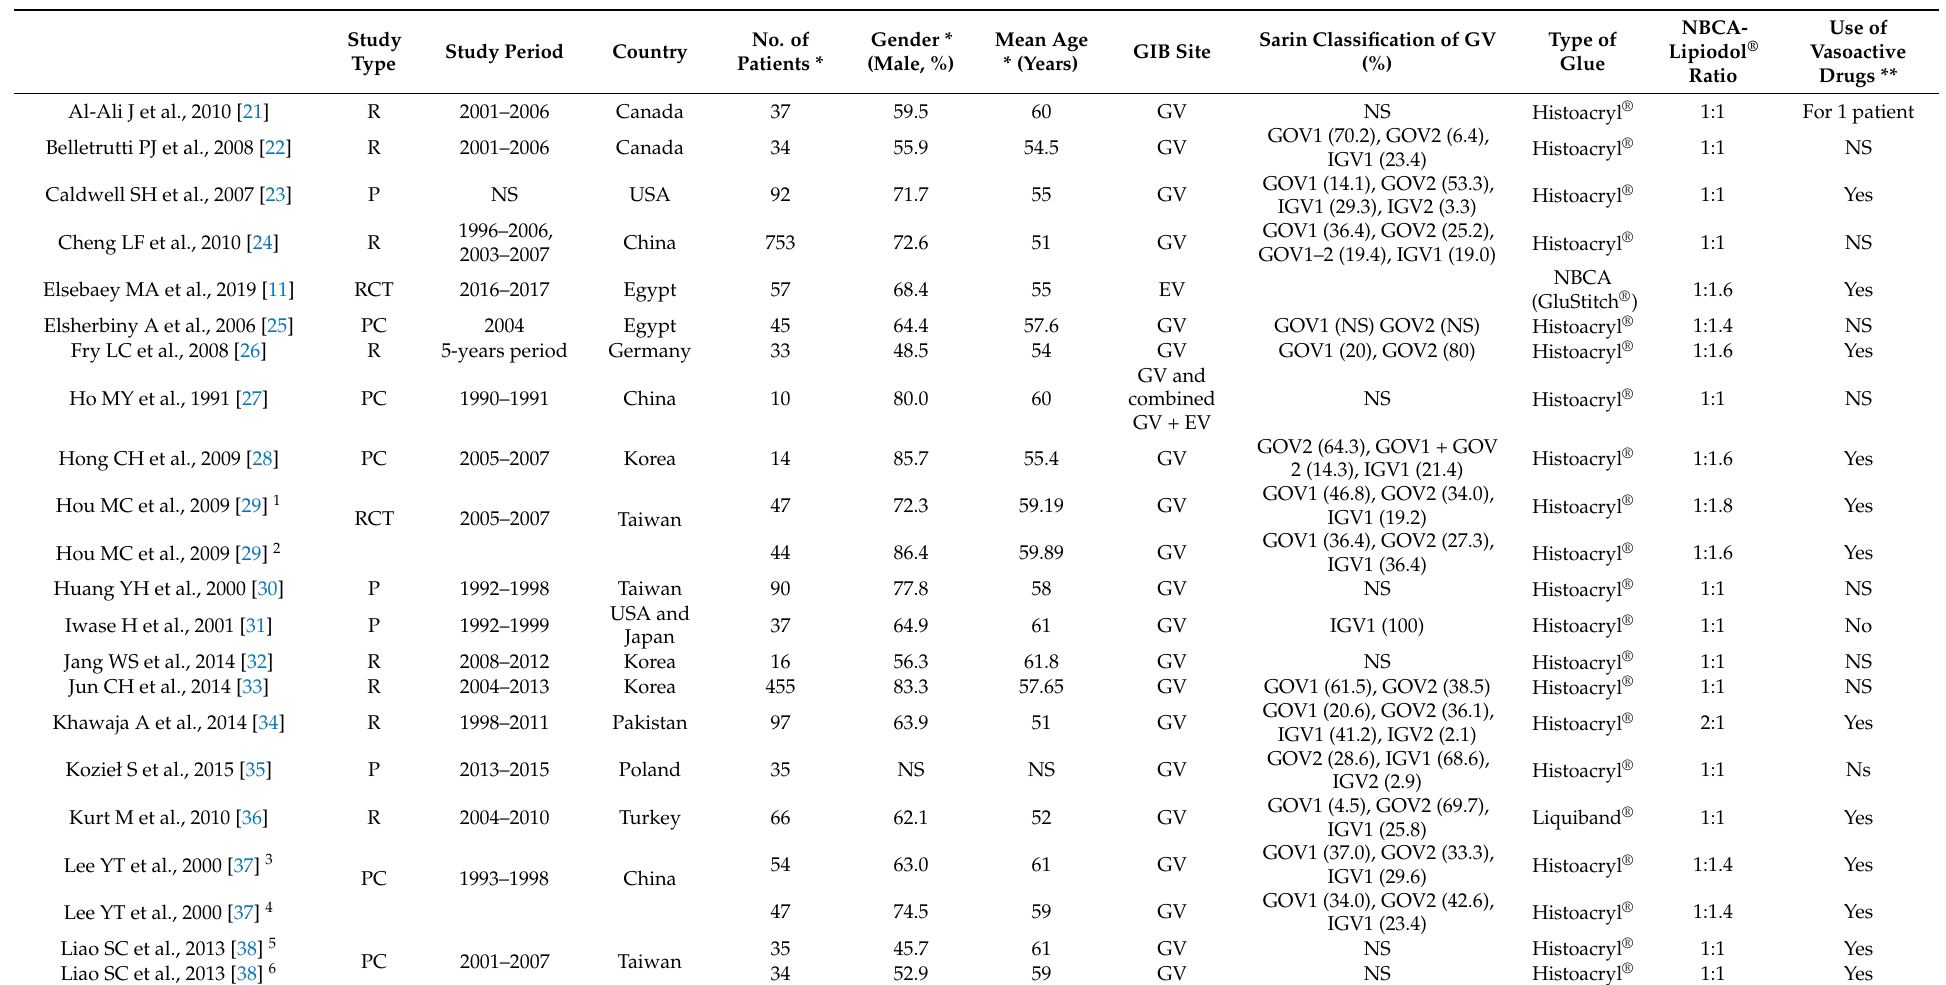
Table 1. Characteristics of the studies included in the